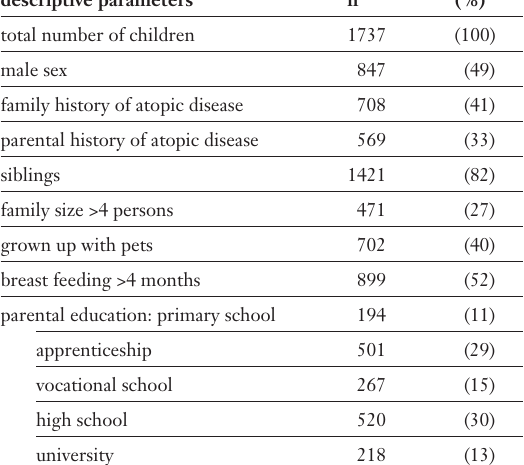
Table 1 Demographic charac- teristics of the study participants, includ- ing known protective and risk factors from the